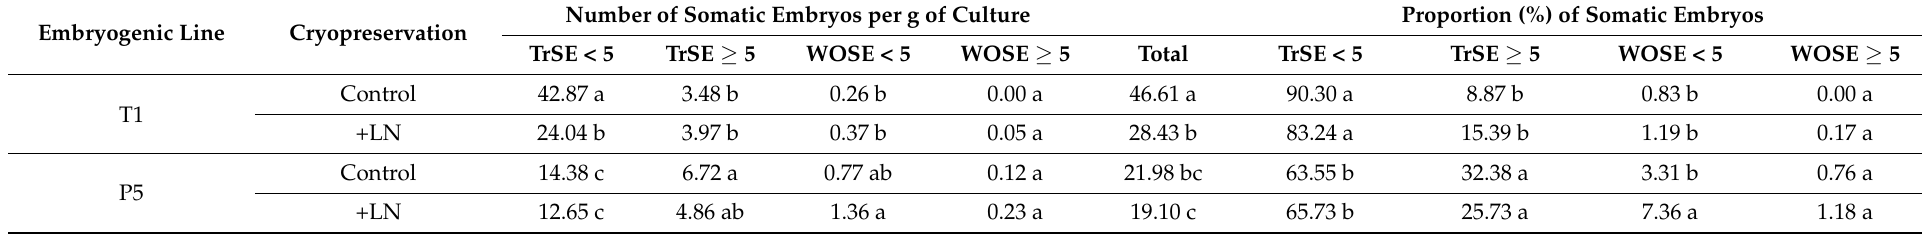
Table 1. Effect of cryopreservation on the capability of embryogenic cultures of the lines T1 and P5 to produce somatic embryos at different developmental stages during the proliferation phase. Production of somatic embryos at different developmental stages expressed per gram of culture and proportionally with respect to the total number of embryos obtained. Data assessed six weeks after the last subculture. Different letters indicate significant differences by the LSD test with a significance level of 0.05.